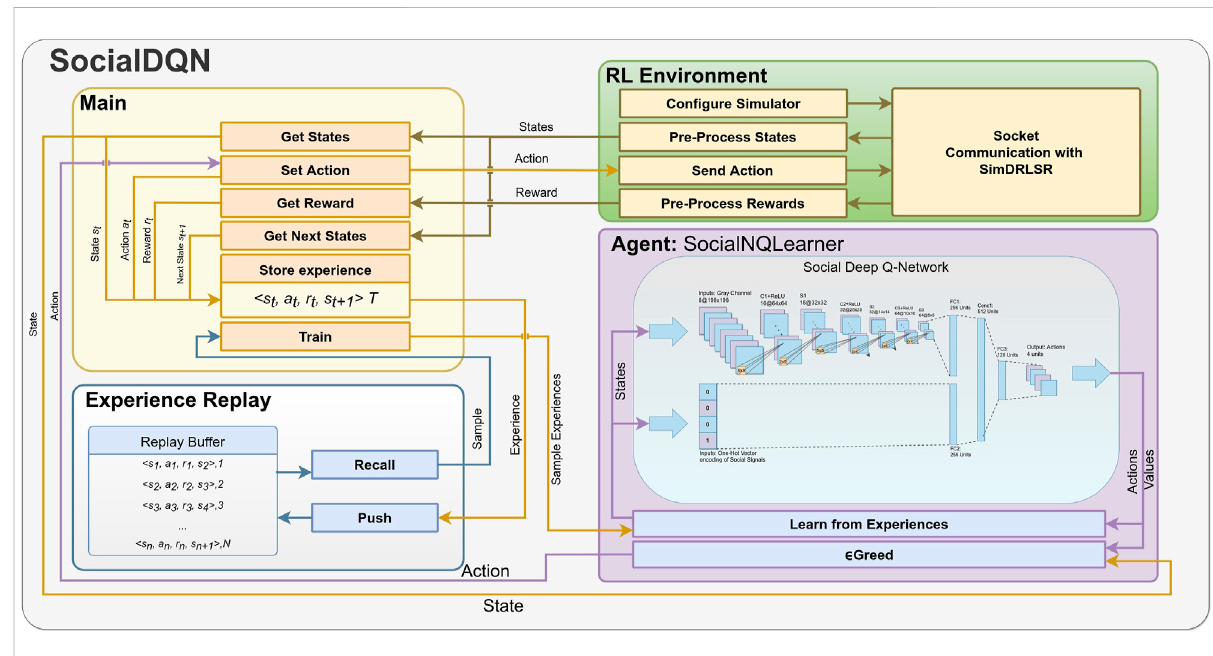
FIGURE 3 The SocialDQN architecture follows the pattern of a traditional reinforcement learning system. The agent captures the states, selects an action through apolicy ( ϵ -greedy), receives areward, extracts state information again, and stores theinteraction information in areplay buffer. Periodically, the system trains the model. The cycle is repeated until the algorithm reaches a terminal state, and it can restart this cycle for n